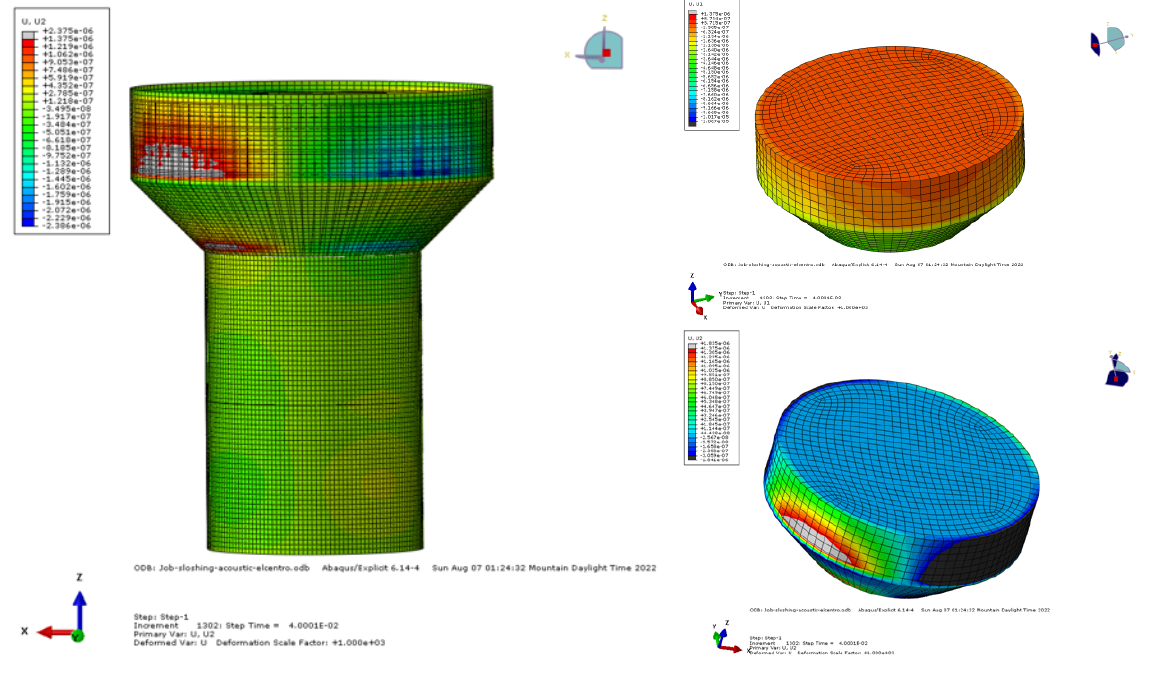
Figure 8. Deformation of the tank and the water content under the influence of El Centro earthquake’s ground motion . Table 1. Maximum absolute time history response values for the elevated tank model .